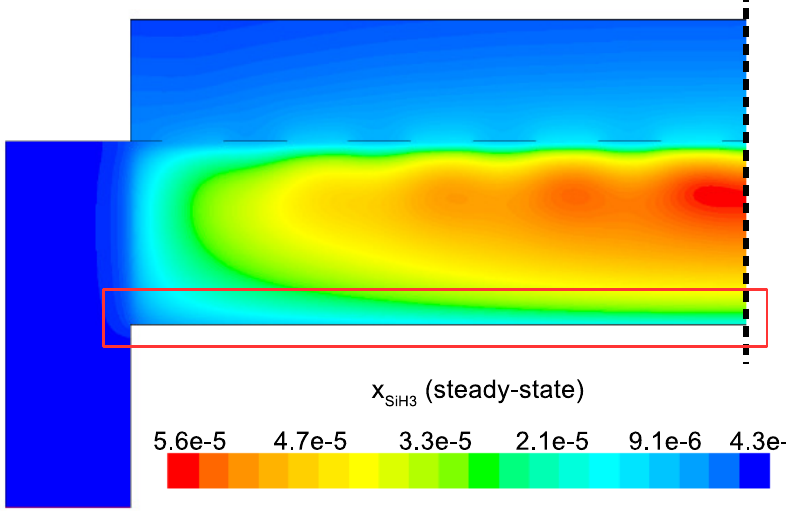
Figure 21. Radial gradient in the concentration of SiH 3 above the wafer surface.